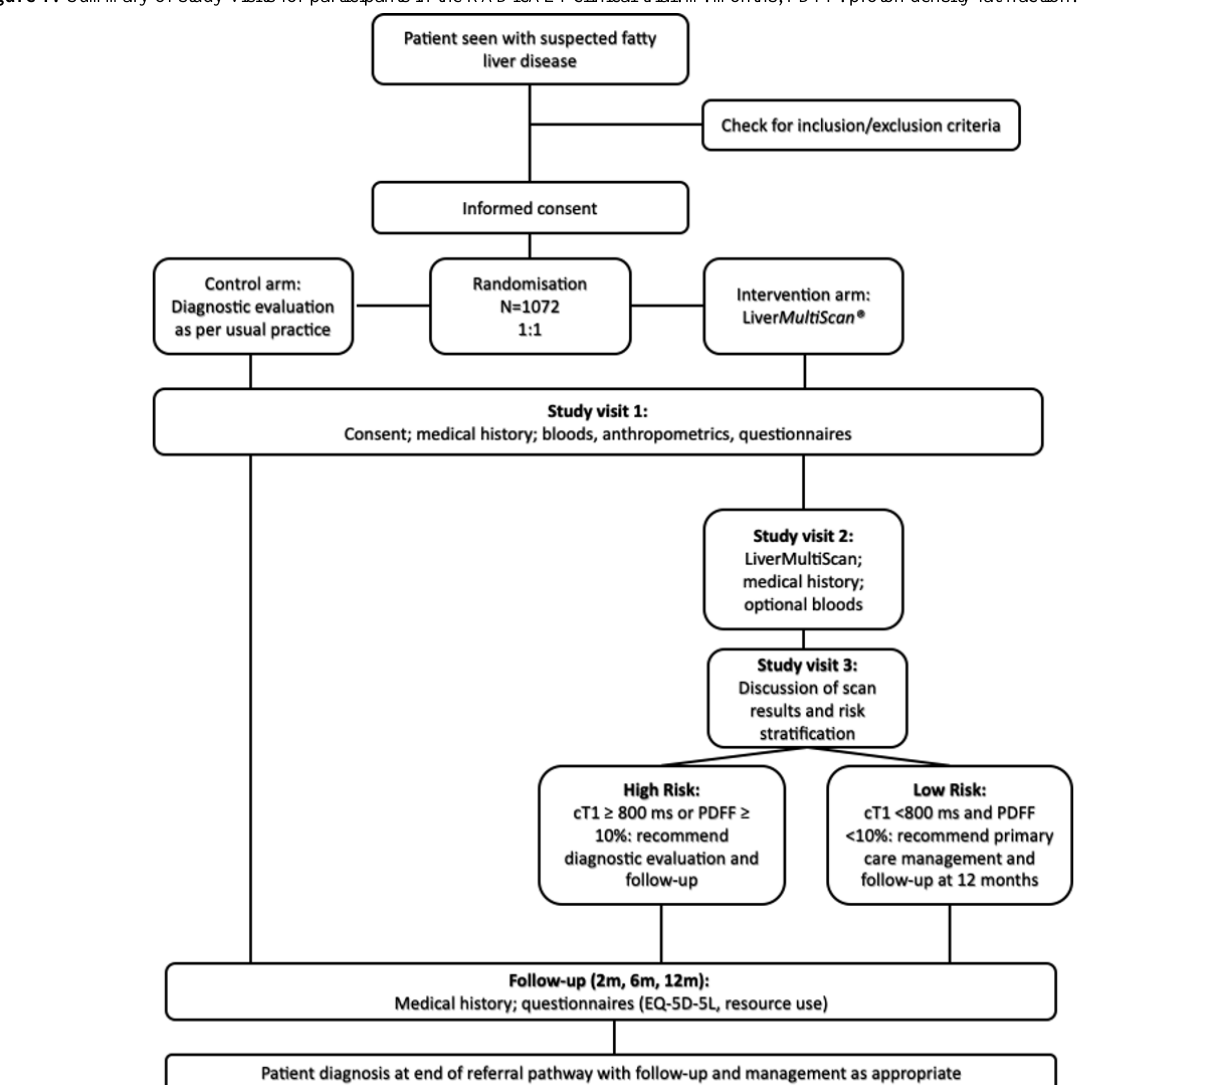
Figure 1. Summary of study visits for participants in the RADIcAL1 clinical trial. m: months; PDFF: proton density fat